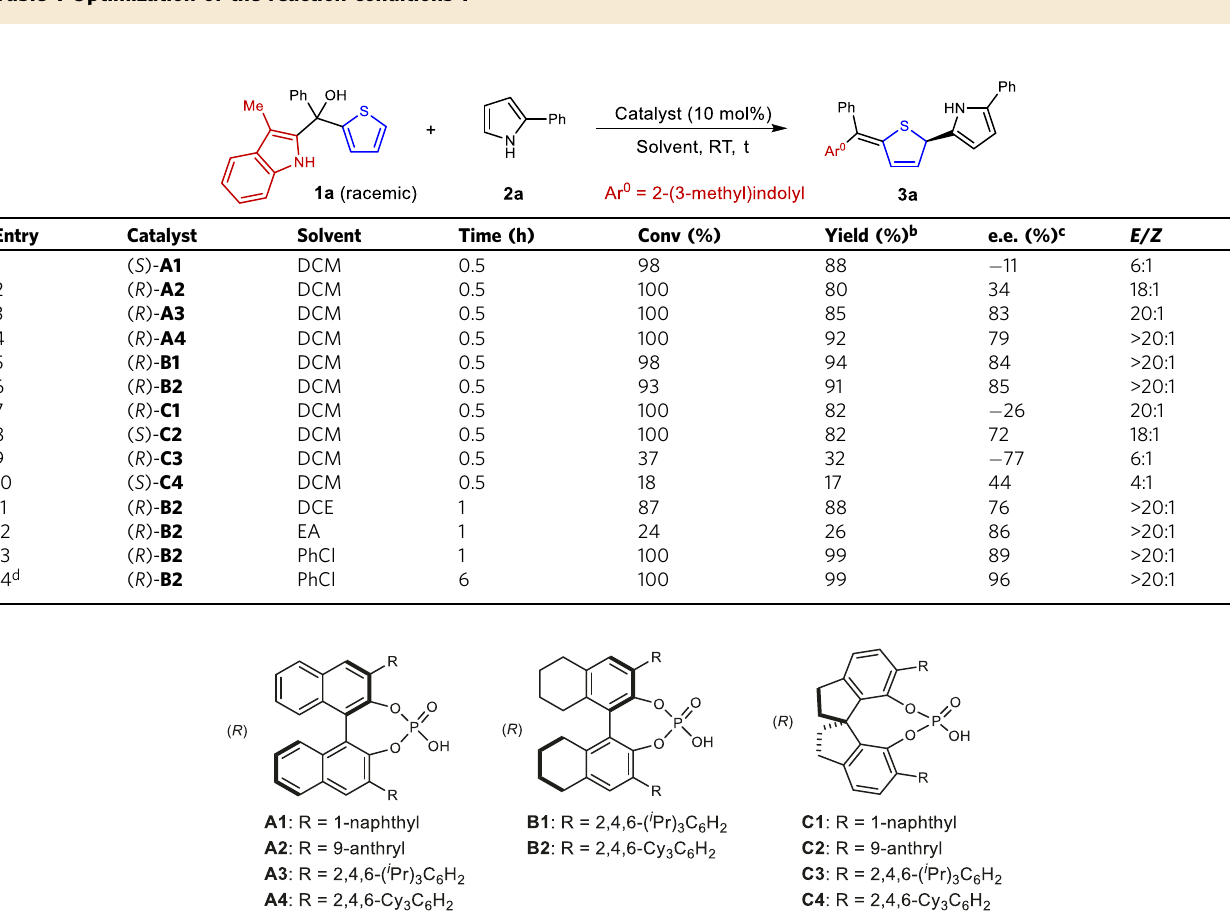
Table 1 Optimization of the reaction conditions a